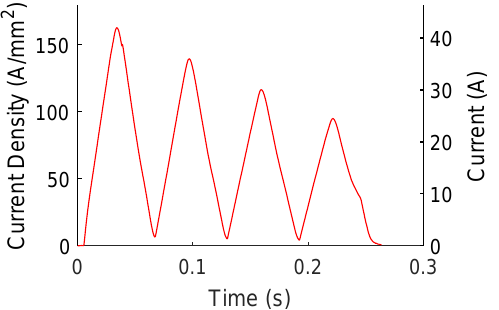
Figure 10. Current waveform response of Ametek Sorenson SGA 10/1200 power